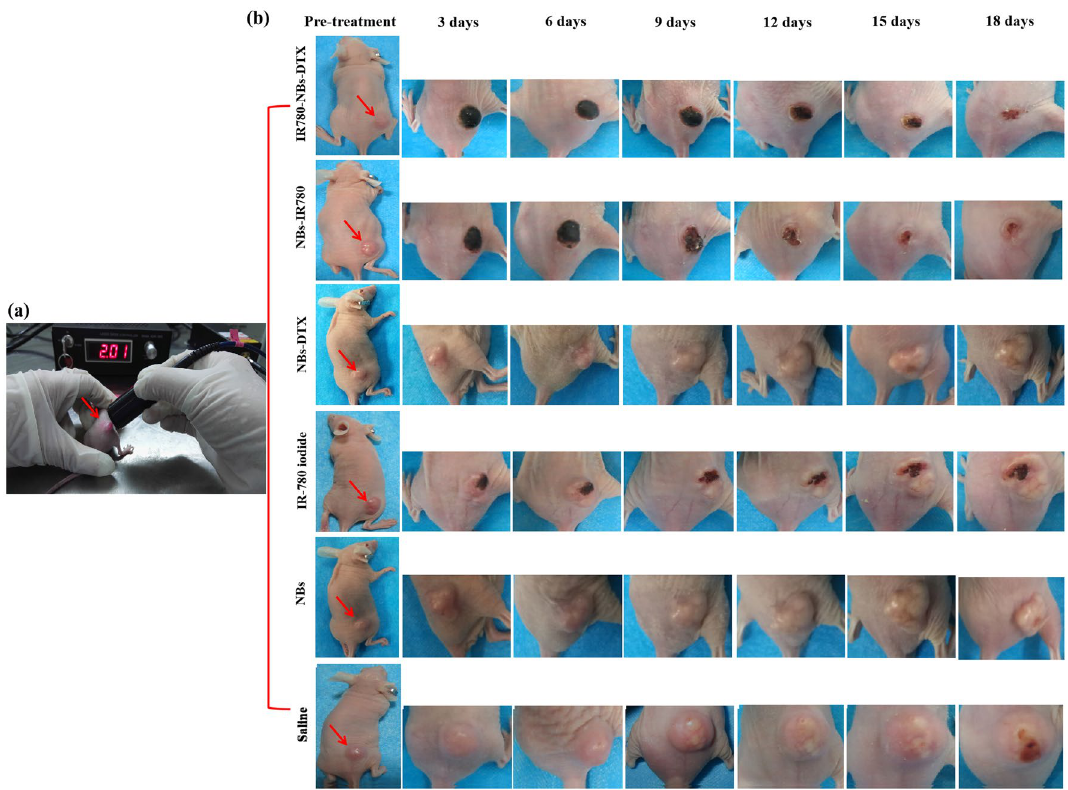
Figure 12. Photothermal ablation combined with chemotherapy mediated by IR780-DTX-NBs for pancreatic cancer xenografts. ( a ) Photothermal ablation of the tumor (indicated by red arrow) via a photothermal therapeutic instrument (1 w/cm 2 , 210 s). ( b ) Changes in tumor volume (indicated by the red arrow) after